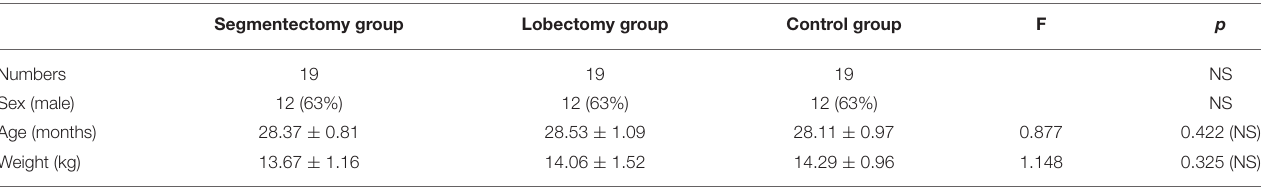
TABLE 3 | Comparison of demographic data at PFT (2 years after surgery).